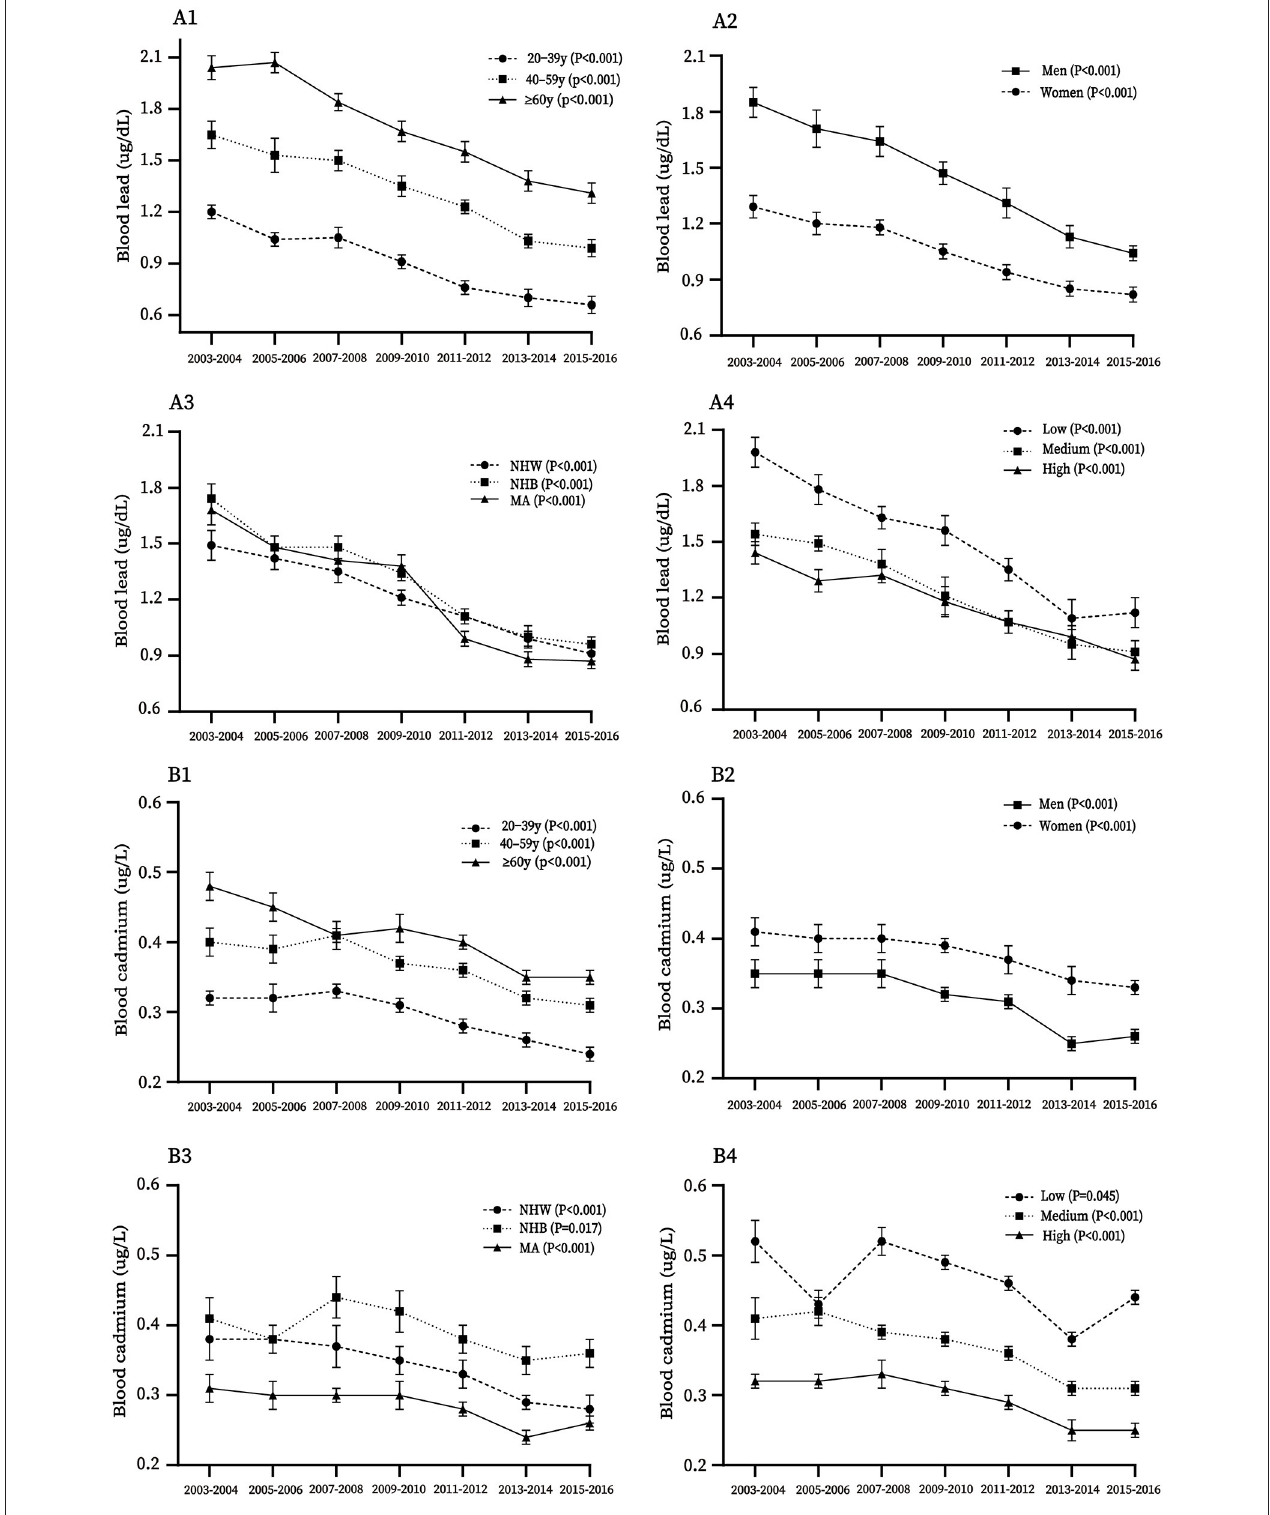
FIGURE 2 | Trends of concentrations of blood lead (A1–A4) and cadmium (B1–B4) by age, sex, race-ethnicity, and socioeconomic status (SS) among US adults from 2003 to 2016. MA, Mexican American; NHW, non-Hispanic white; NHB, non-Hispanic black.